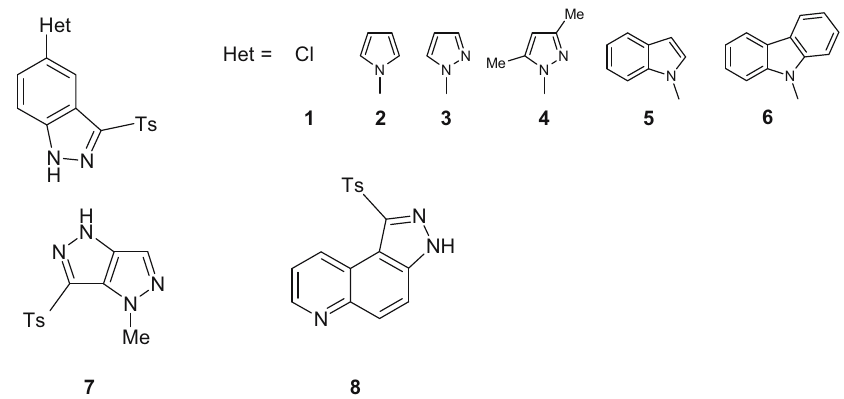
Scheme 1: The investigated azoles as potential kinase